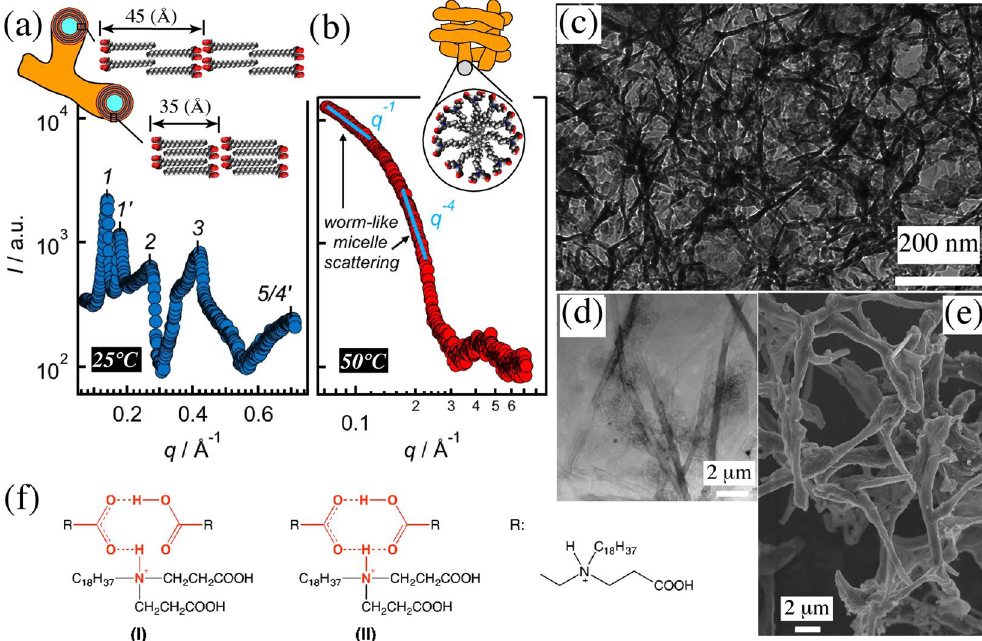
Figure 4. For 2% pH = 5.37 hydrogel, L-XRD, SEM, TEM and cryo-TEM data, and the results of the interpretation of IR data (IR data itself can be found in Supplementary Fig. S9). L-XRD data and the schematics of the essential features of gel microstructure at ( a ) 25 °C (crystalline bilayers) and ( b ) 50 °C (worm-like micelles), ( c ) cryo-TEM image of a 50 °C sample, ( d ) TEM image of a 25 °C sample, ( e ) SEM image of a 25 °C sample, and ( f ) possible configurations of carboxylic acid:amine 2:1 complex observed by IR at 25 °C. In ( a ) the order of observed peaks for two lamellar structures are indicated. In ( b ), the very broad peak of the L-XRD intensity pattern is centred at 0.433 (Å − 1 ) [see text]. Also, the results of fits of power law functions of I = Kq α ( α = − 1 and − 4) to the intensity pattern of ( b ) are shown (see